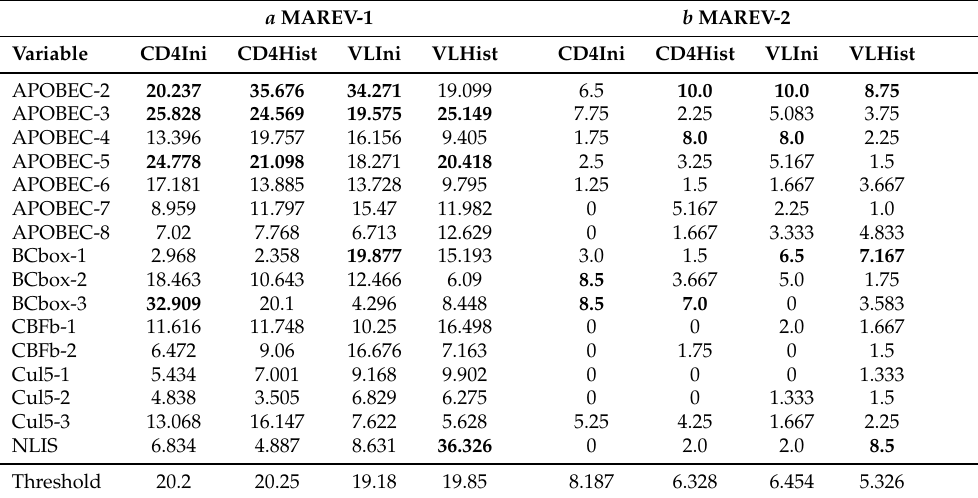
Table A6. The most informative variables per clinical endpoint considering those surpassing a calculated threshold (relevance scores in boldface). a , Scores when considering the classifications results from all the combinations; b , Scores calculated using only the best classification performance per clinical endpoint and algorithm (see Table 2).